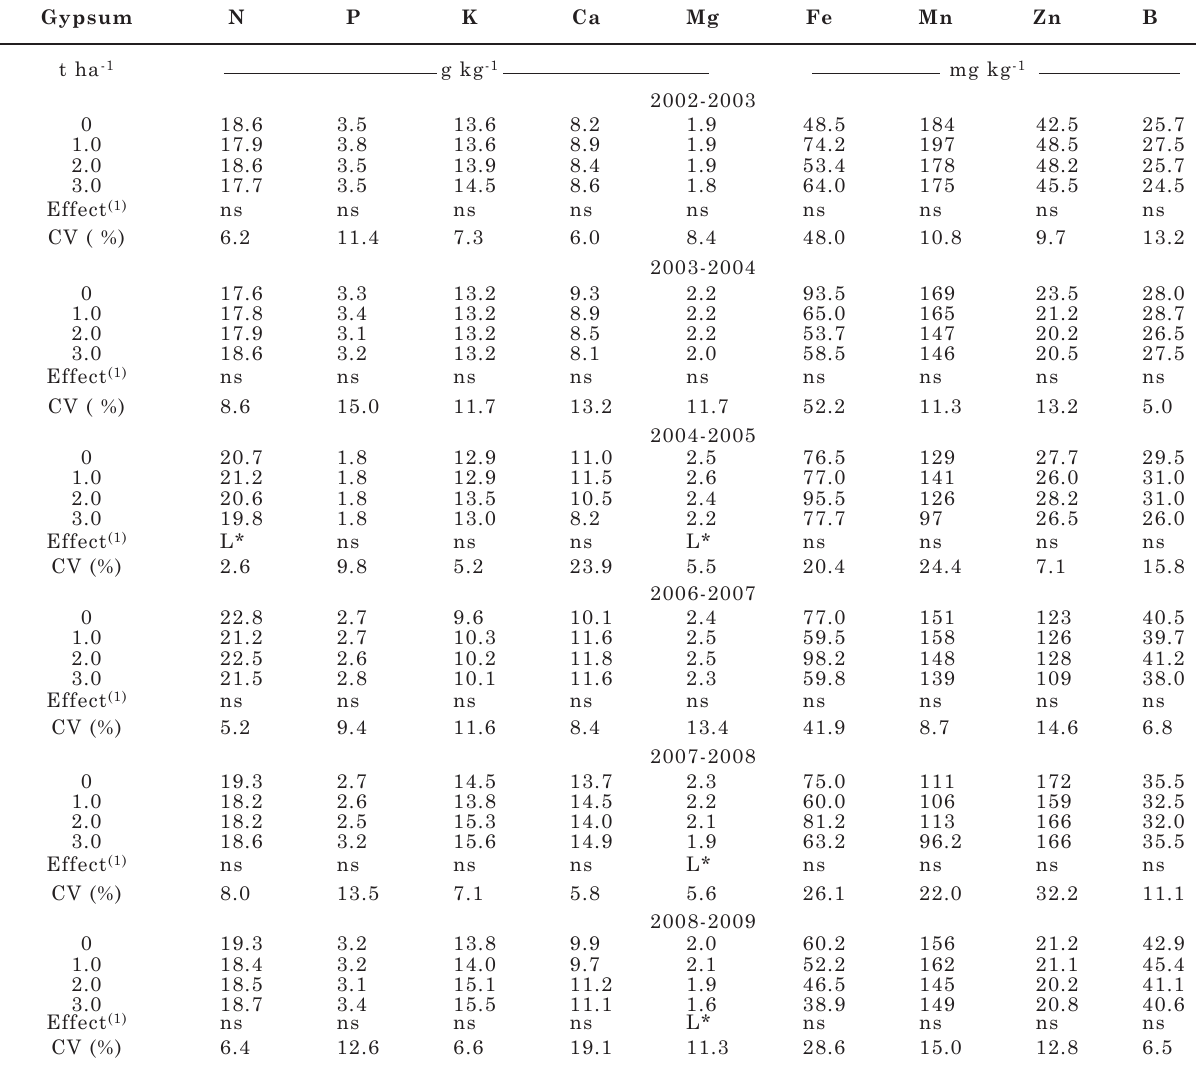
table 3. Concentrations of n, p, K, Ca, mg, fe, mn, Zn, and b in apple leaves, as affected by annual rates of gypsum applications broadcast on the soil surface, from 2001 to 2009 gypsum n p K